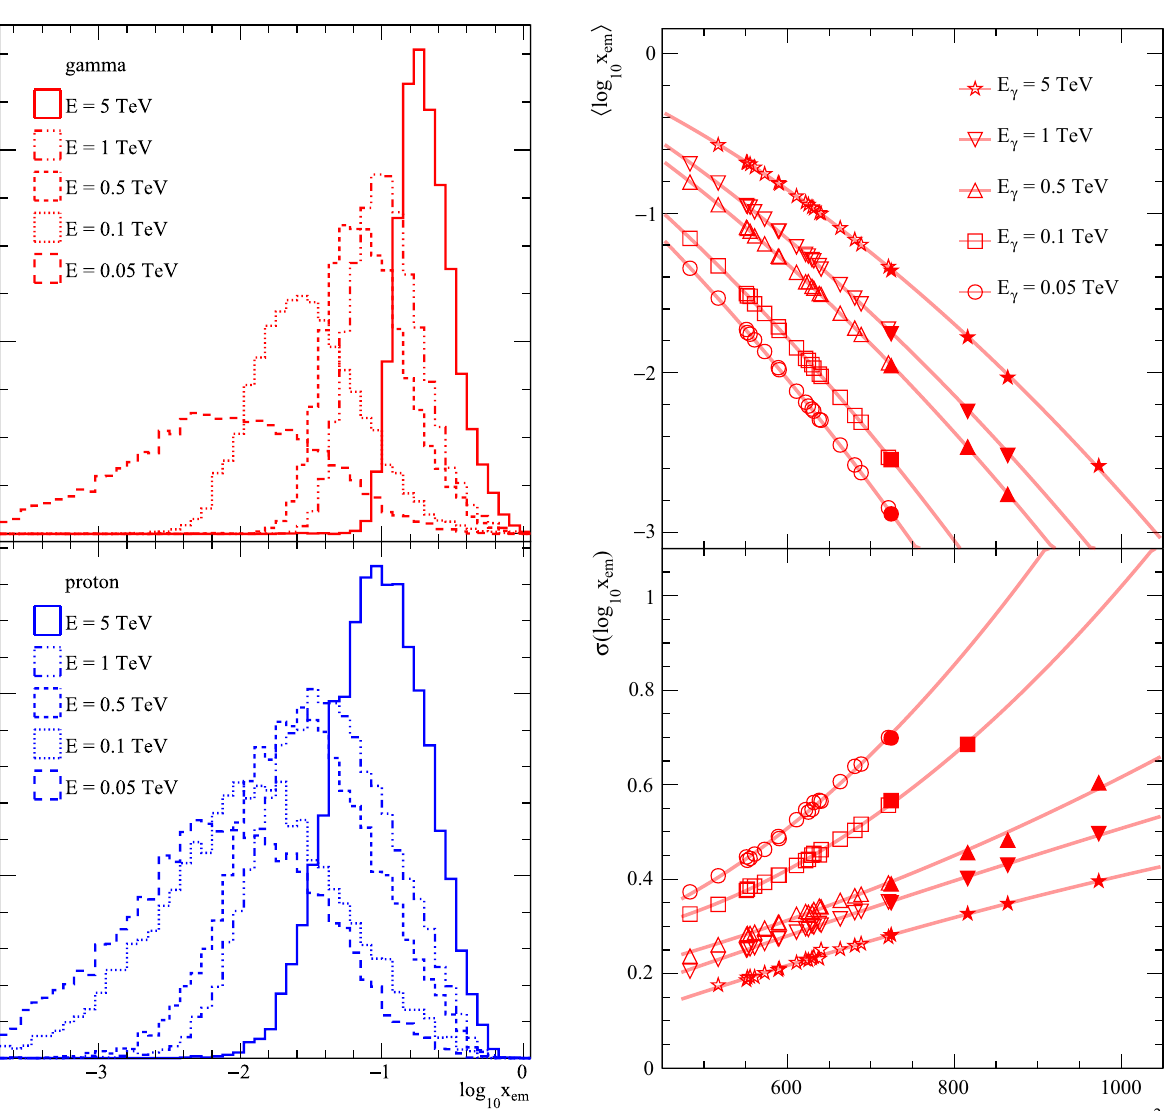
sample, we omit the sample completely from Figs. 5 and